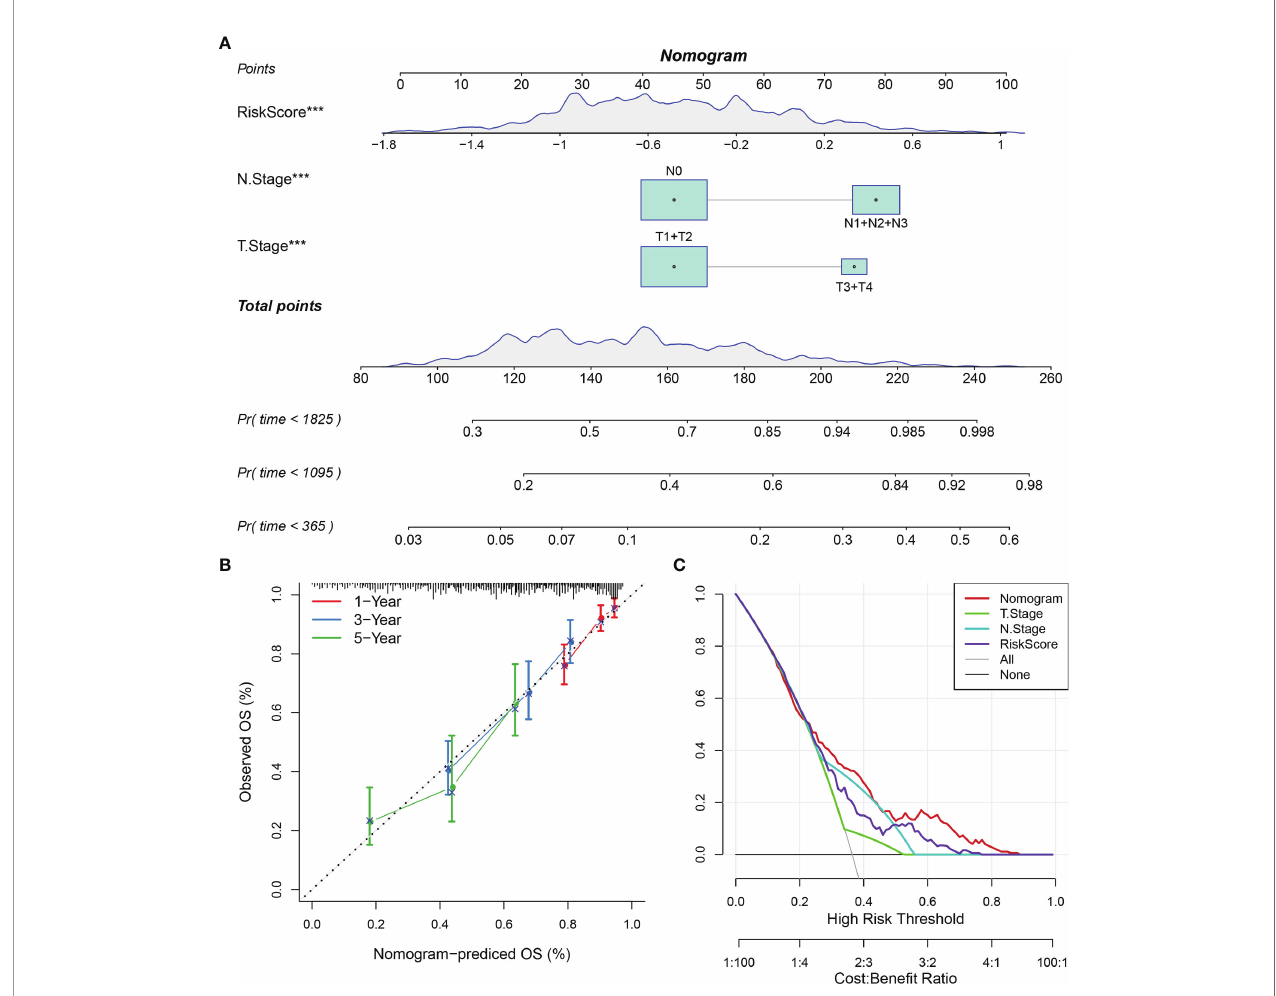
FIGURE 13 | Nomogram and forest plot constructed with RiskScore and clinical features using the TCGA-LUAD dataset. (A) Nomogram of RiskScore, TNM stage, and recurrence. (B) Correction plot of the nomogram. (C) Decision curve analysis